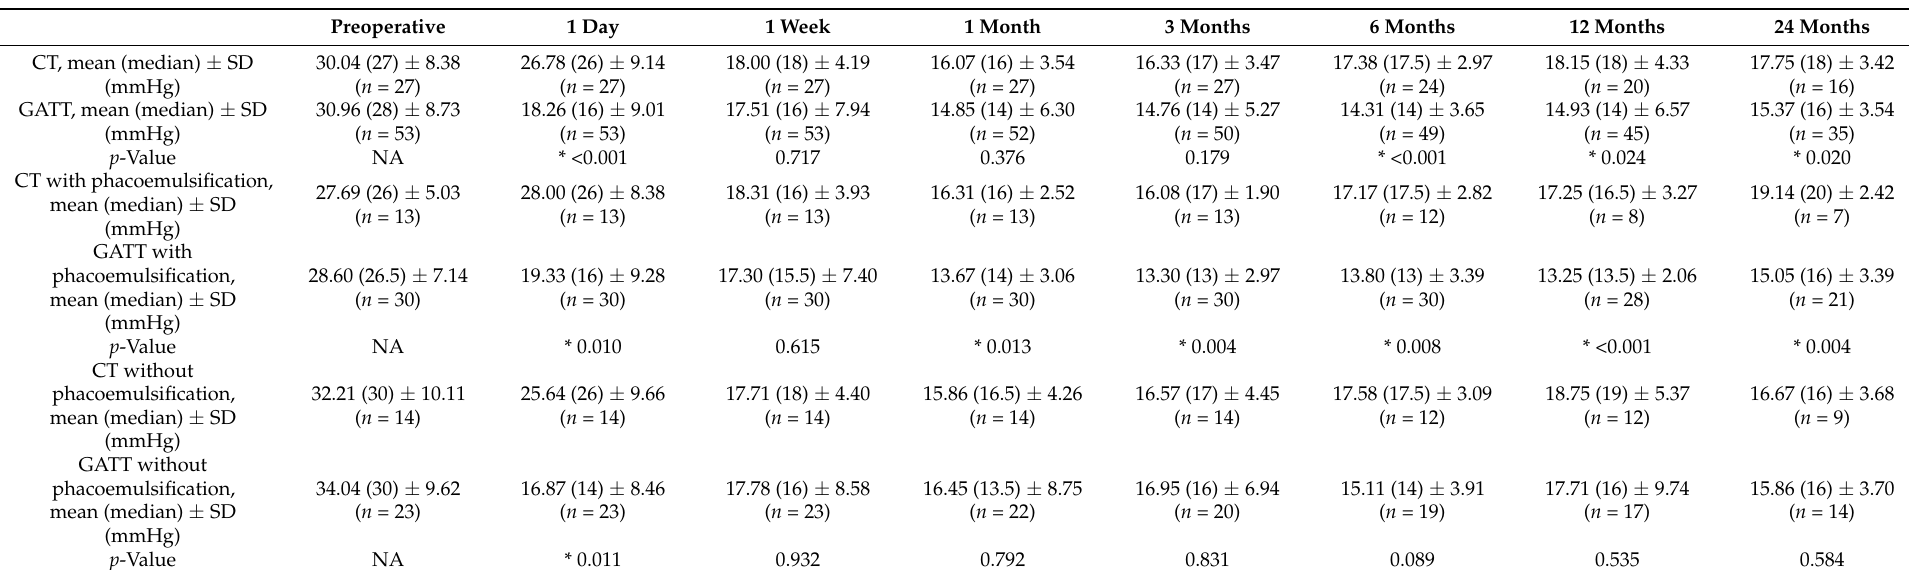
Table 2. Pre- and postoperative IOP in the CT and GATT with and without